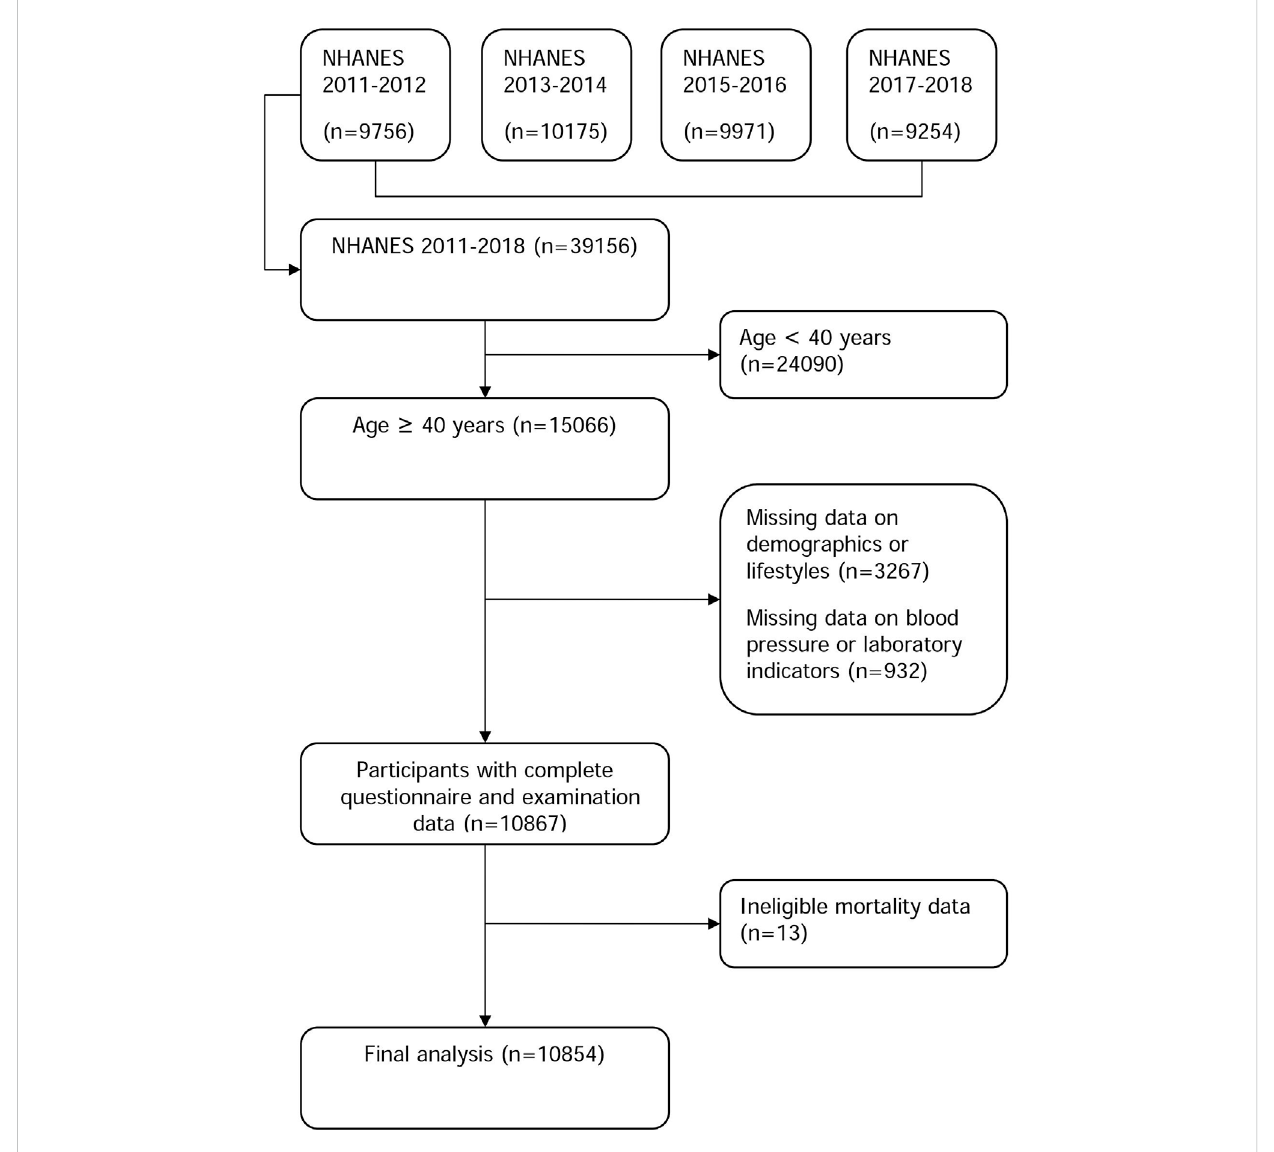
FIGURE 1 Flowchart of the study population